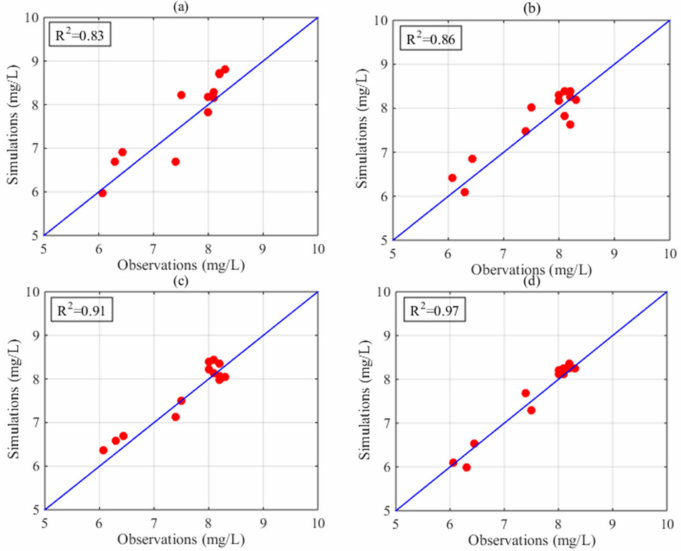
Figure 4. Observed and estimated DO in July from ( a ) cokriging, ( b ) the SVM, ( c ) HASM, and ( d )